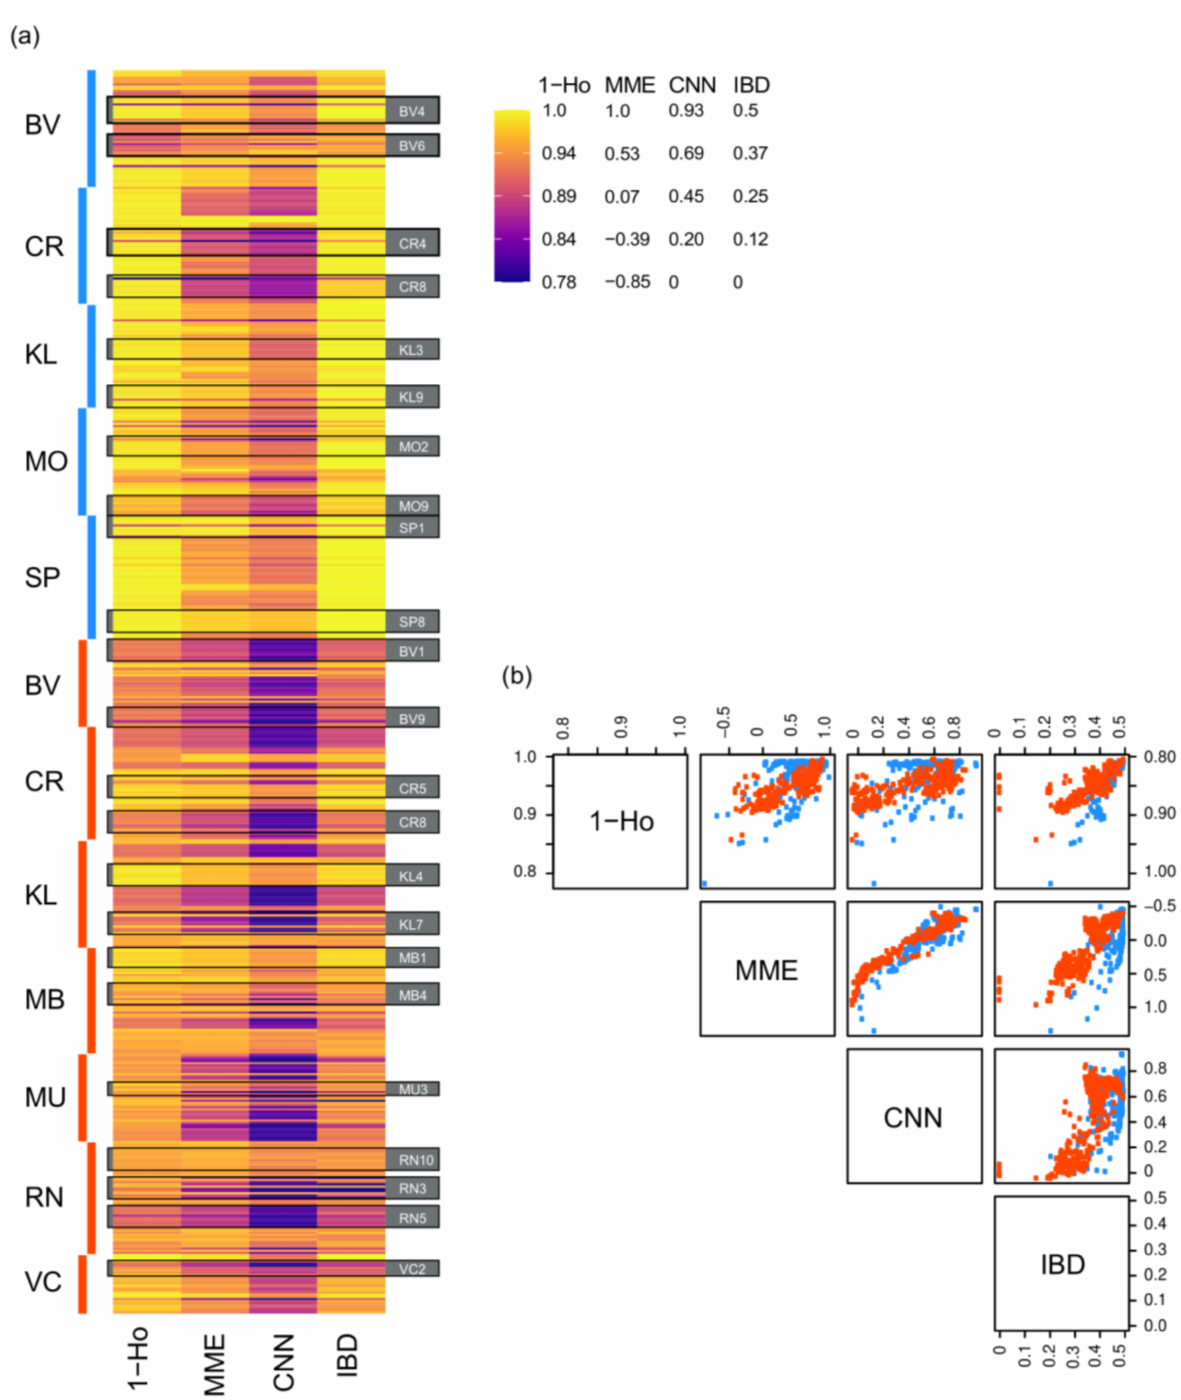
Figure 4. Comparisons among individual progeny of proportion of homozygous loci (1-Ho) and mating system estimates (MME: ˆ s M , CNN: ˆ s C , IBD: mother-progeny kinship coefficient, i.e., identity by descent). ( a ) Heatmap of scaled values side-by-side for each individual (horizontal stripe) grouped by species, site (vertical bar and 2-letter code), and maternal line (example maternal lines from each site are outlined and labeled with black boxes); ( b ) scatterplot matrix showing pairwise comparison of each set of individual